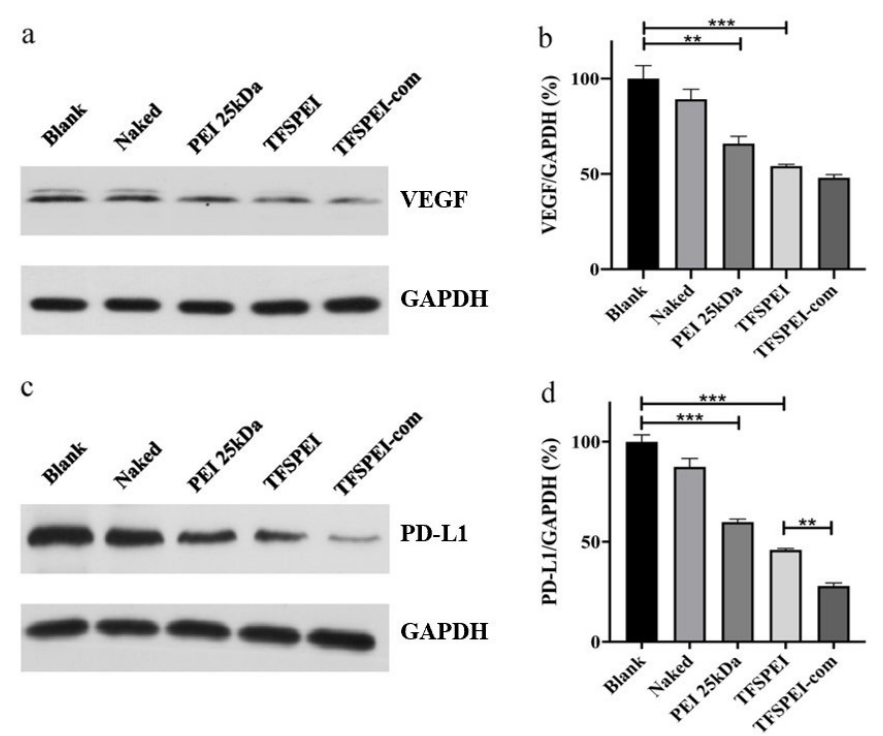
Figure 8. In vitro silencing efficiency of the VEGF and PD-L1 gene. The silencing efficiency of the VEGF ( a ) treated by Western blotting and ( b ) was quantitatively analyzed by ImageJ Pro. The silencing efficiency of the PD-L1 ( c ) treated by Western blotting and ( d ) was quantitatively analyzed by ImageJ Pro. Data are shown as the mean ± S.D. (n = 3, ** p < 0.01, *** p < 0.001).